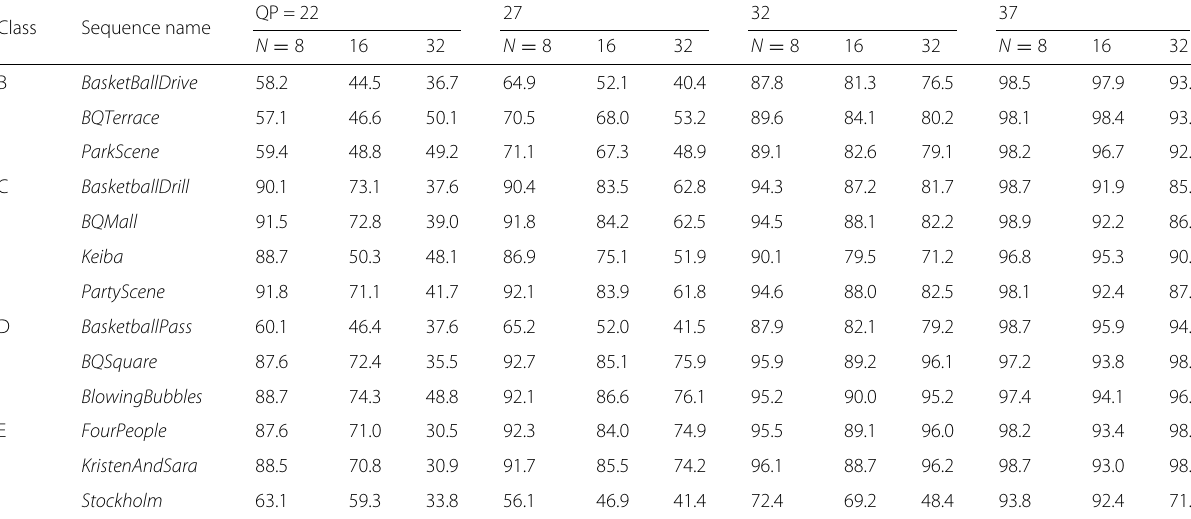
Table 3 Resulting η (%) values of the proposed two-step method for a subset of the tested image sequences